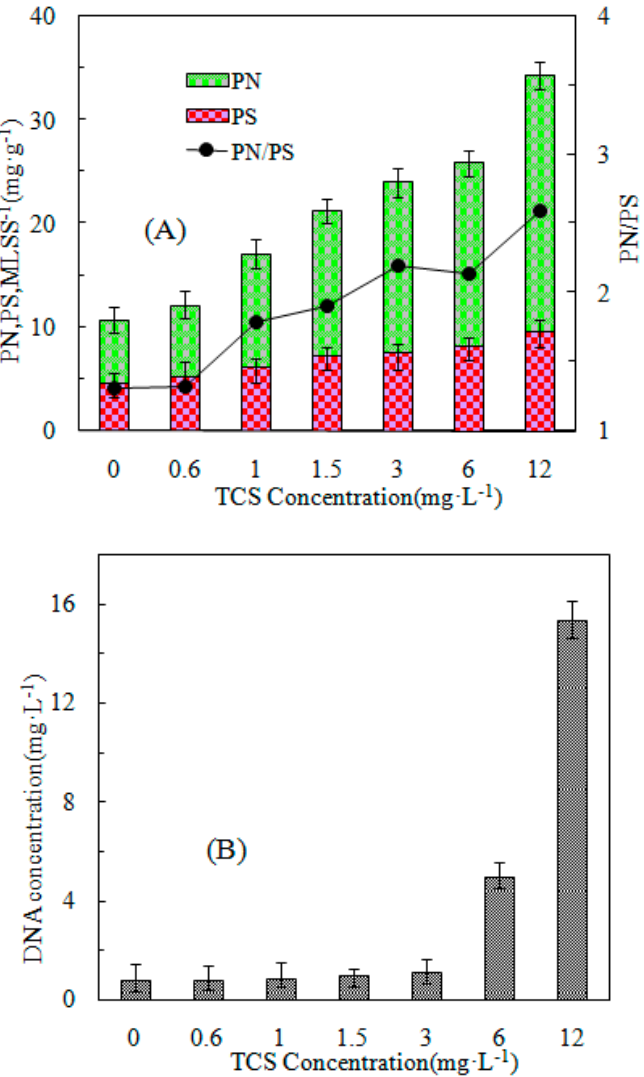
Figure 4. ( A ) Protein / polysaccharide and EPS concentration variations in terms of PN and PS extracted at different TCS concentrations; and ( B ) DNA concentration in the bulk solution at various TCS concentrations.